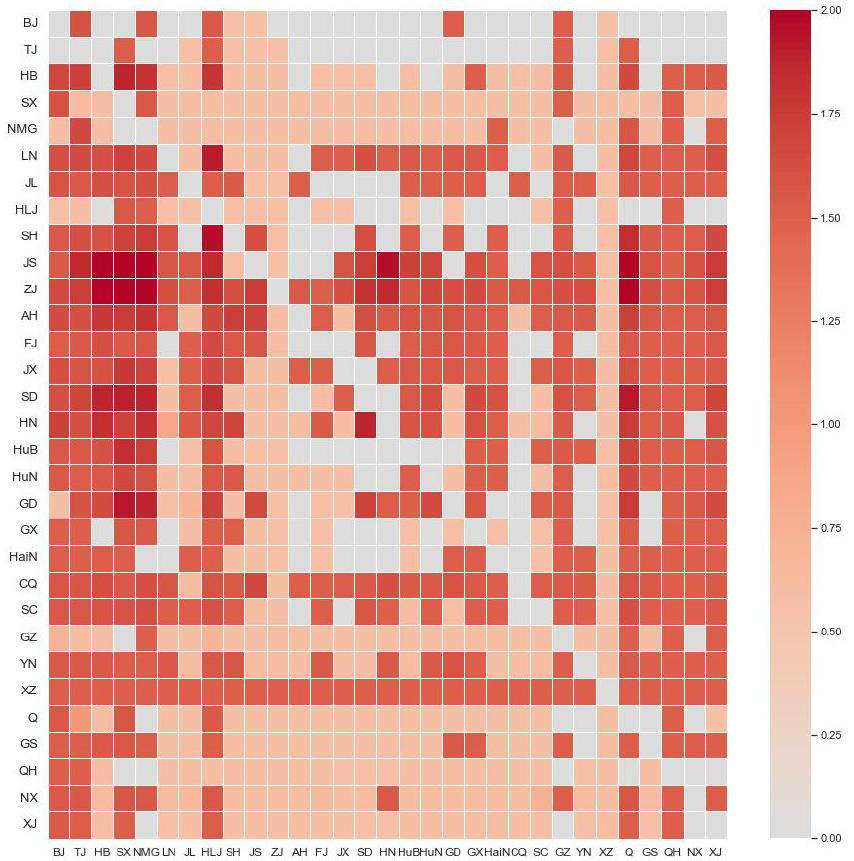
Figure 5. China inter-provincial REI index